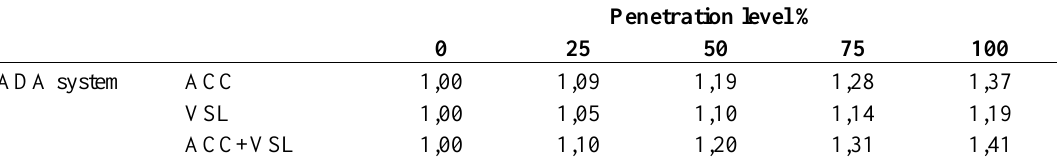
Table 1. Ratio of saturation flows per ADA system over saturation flow for the no- ADAS base case for various penetration levels (HUTSIM simulation